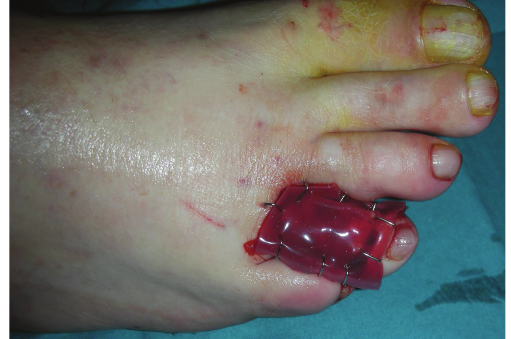
Figure 4: Postop at three